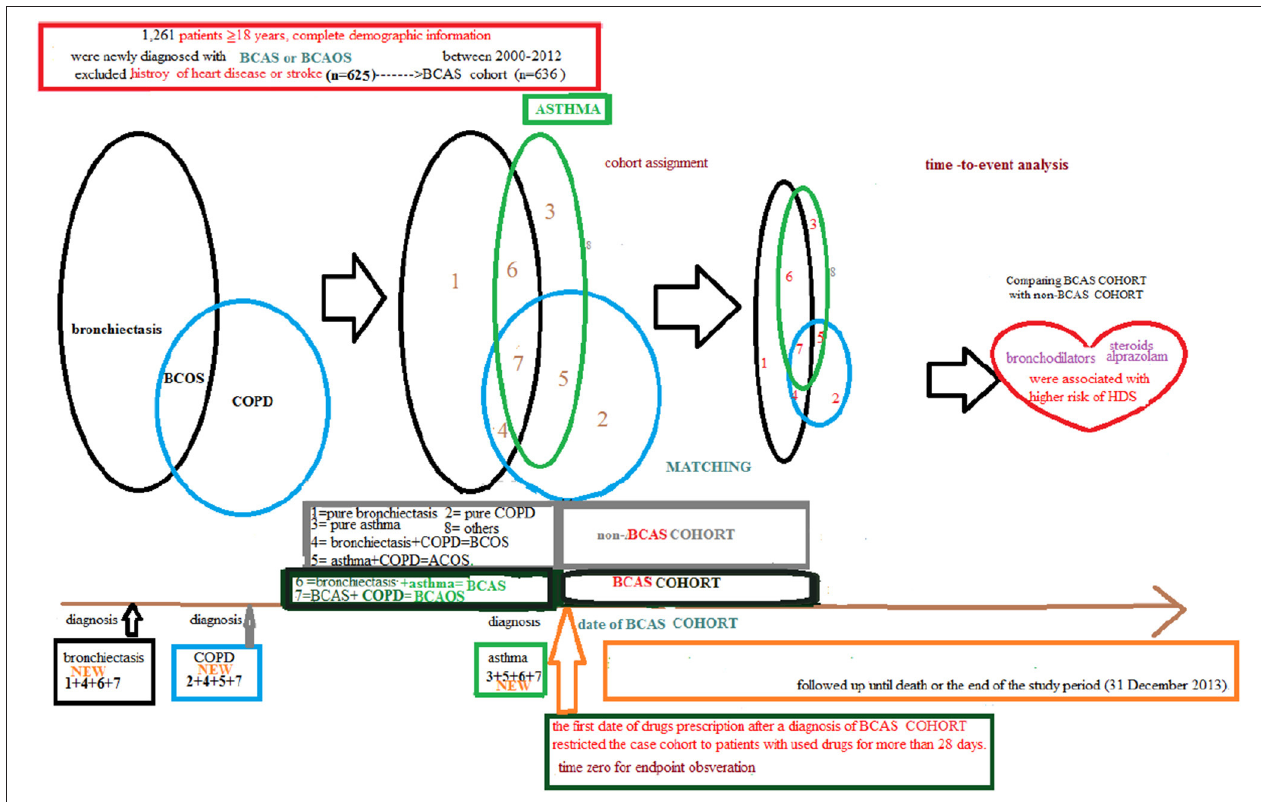
FIGURE 2 | Full name of the subgroups of cohort with bronchiectasis-asthma combination cohort and cohort without the bronchiectasis–asthma combination.